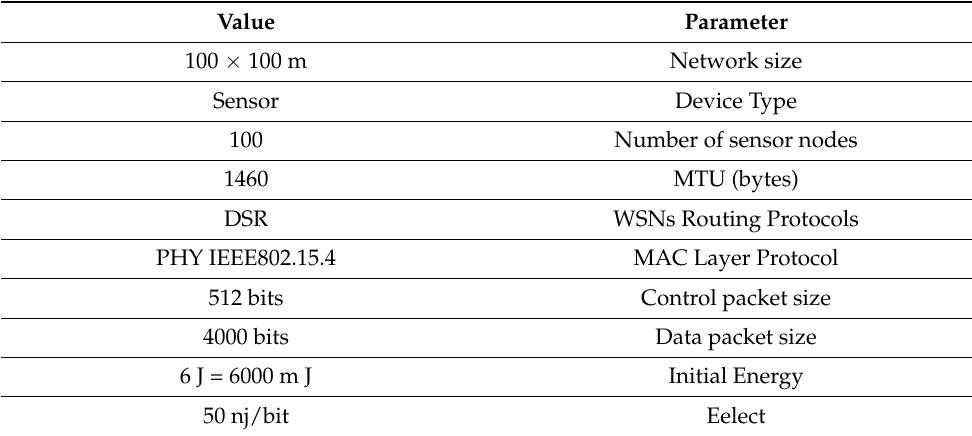
Table 2. Network Simulation